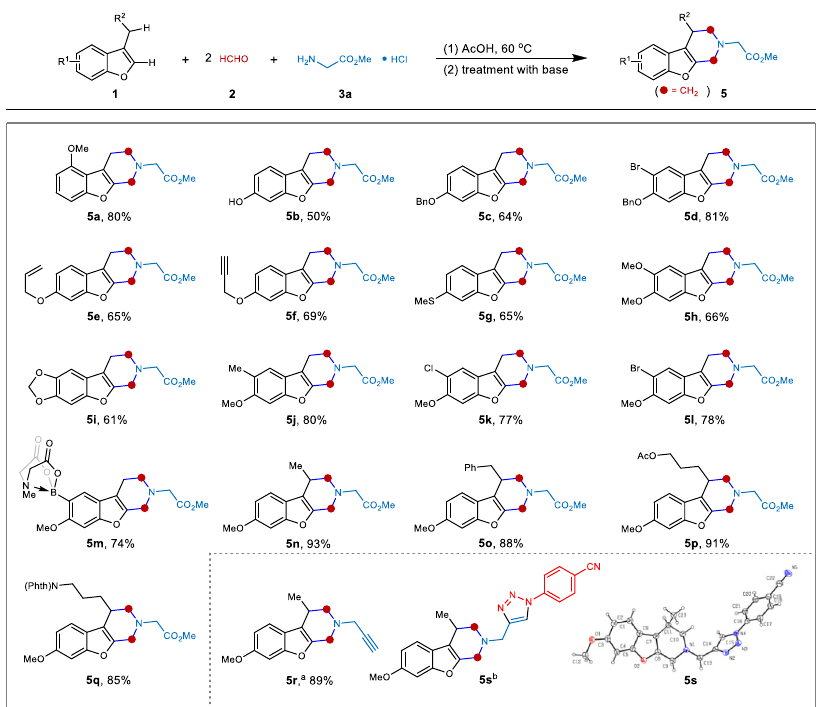
Fig. 4 Substrate scope of heteroarenes. Reactions were carried out under condition A. Yields refer to isolated products. N(Phth) = N -phthalimide. a 3a was replaced with propargylamine hydrochloride under condition B. b 5s was prepared from 5r via click reaction.